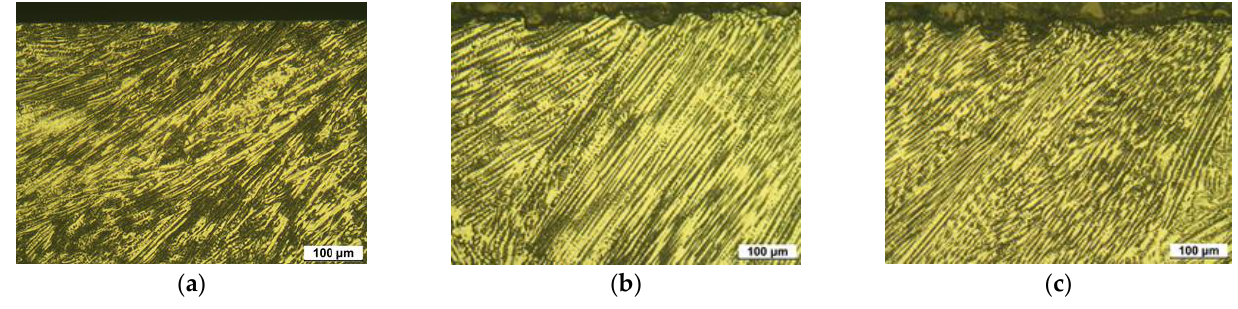
Figure 9. Optical microstructure of the cross-section of 304L weldment area after laser peening (OM, × 200, 10% oxalic acid): ( a ) 304LB, ( b ) 304LB-L-NC, and ( c ) 304LB-L-WC.